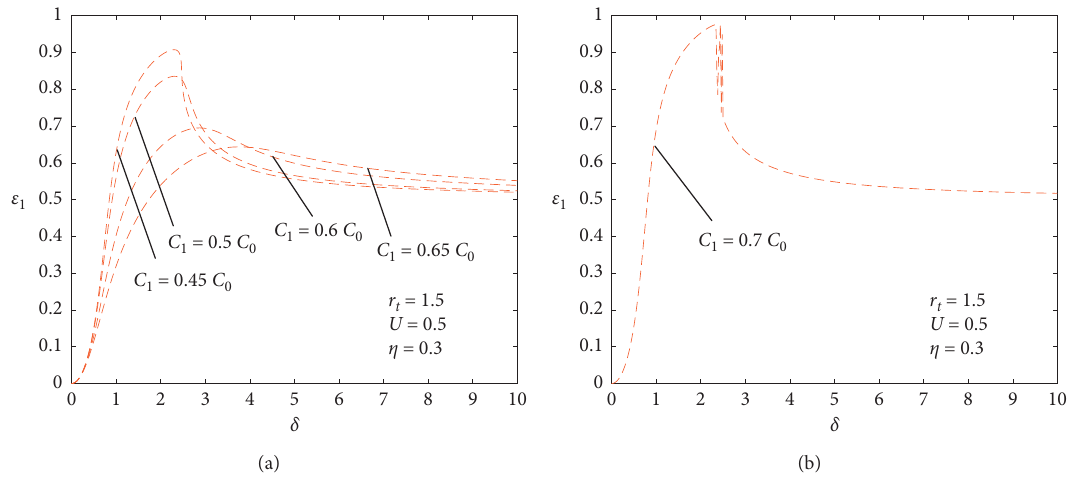
Figure 10: The influence of C on the unbalance response of the rotor-DCSFD system: (a) stability; (b) instability. 1